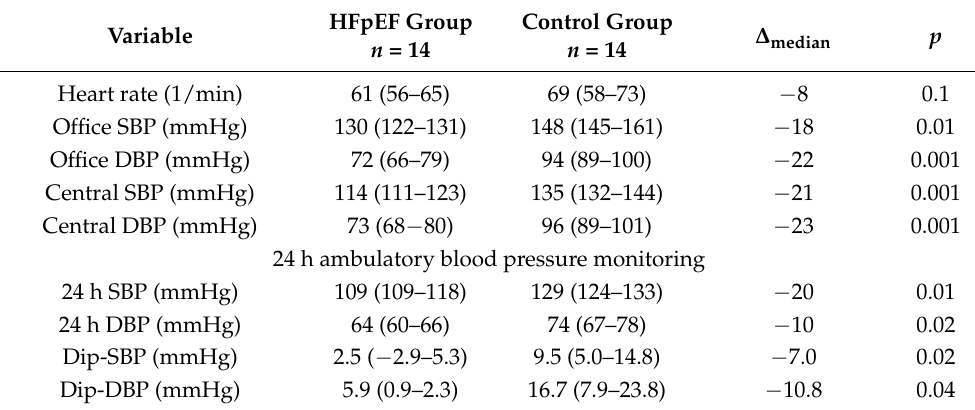
Table 2. Differences in blood pressure measured using different techniques between HFpEF and control